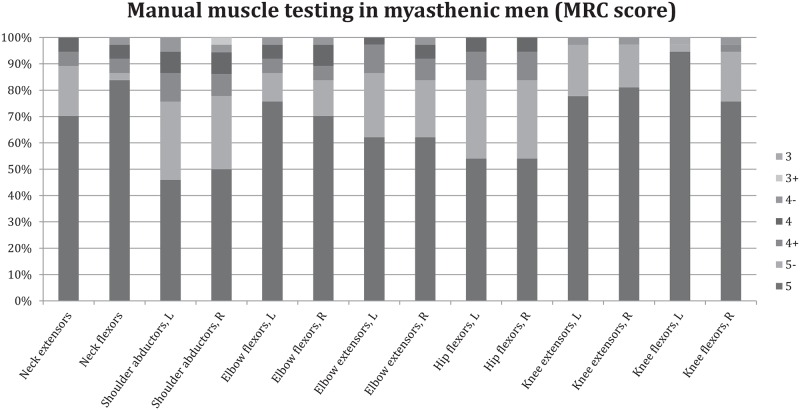
Manual muscle testing in eight muscle groups using the Medical Research Council (MRC) score in male patients with generalized myasthenia gravis.L = left side & R = right side.